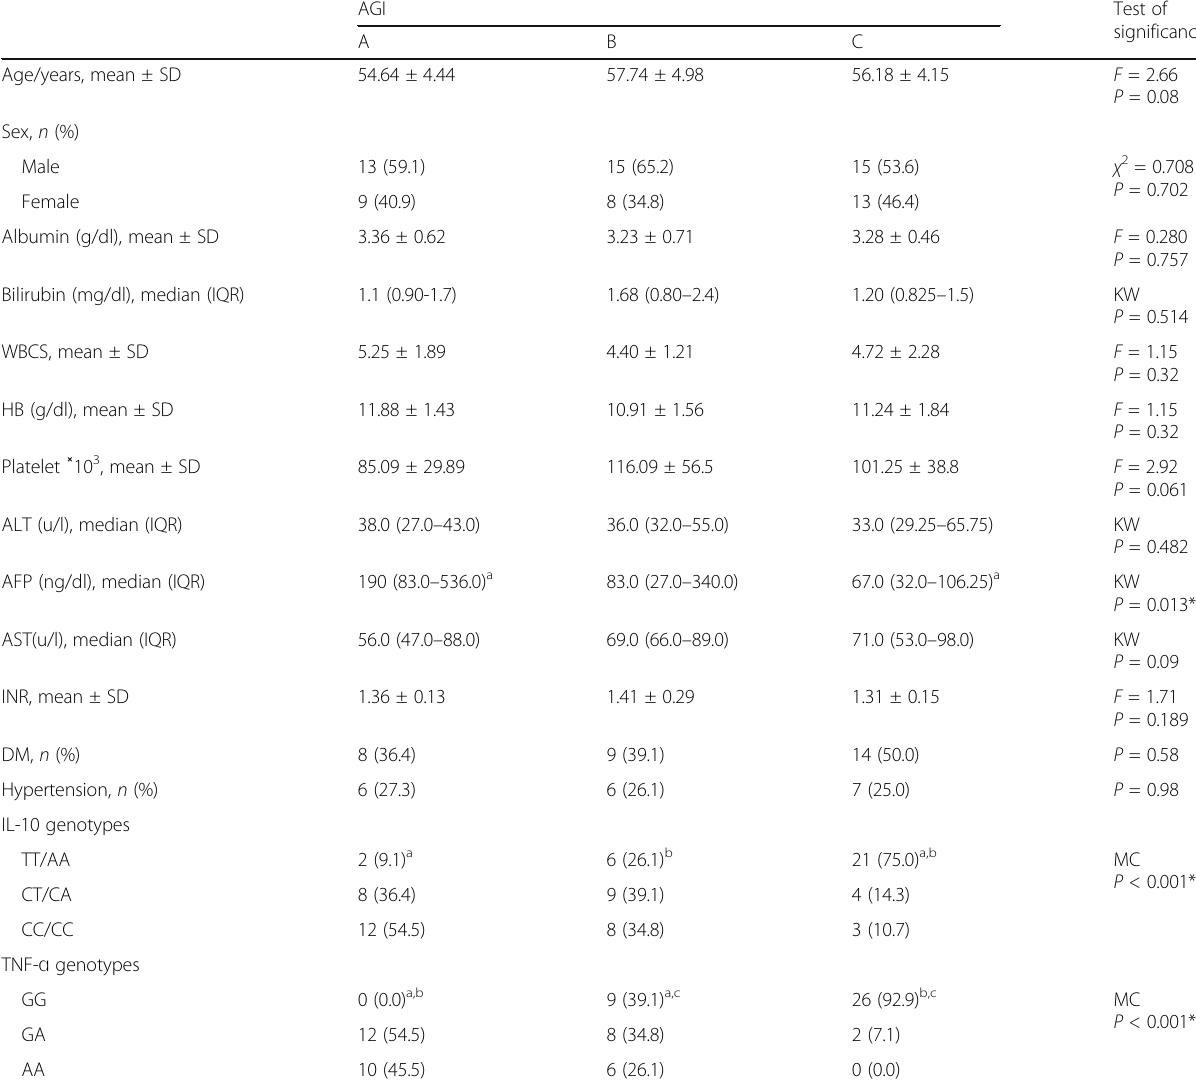
Table 6 Association of HCC aggressiveness index with sociodemographic and clinical characteristics and genotype of HCC cases AGI Test of